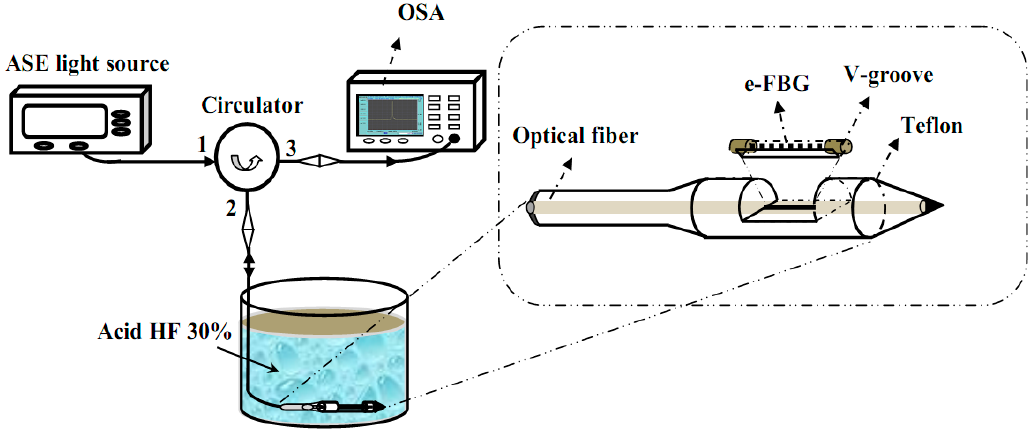
Figure 1. Experimental setup and mount design for making etched-fiber Bragg grating (e-FBG). ASE: amplified spontaneous emission; OSA: optical spectrum analyzer.